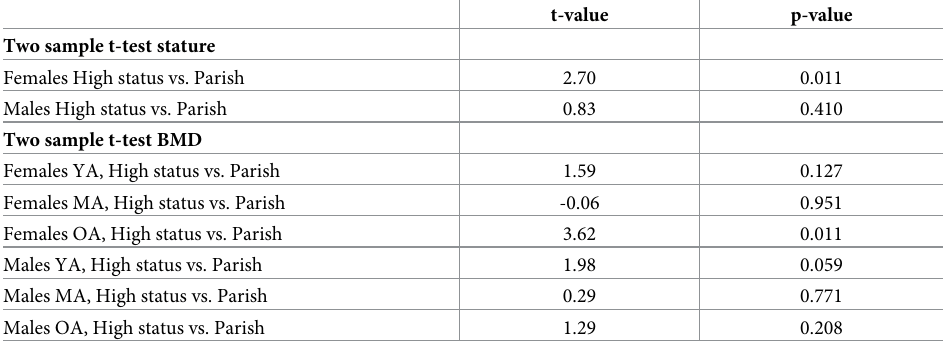
Table 4. Results of the two sample t-tests for stature and BMD comparisons.